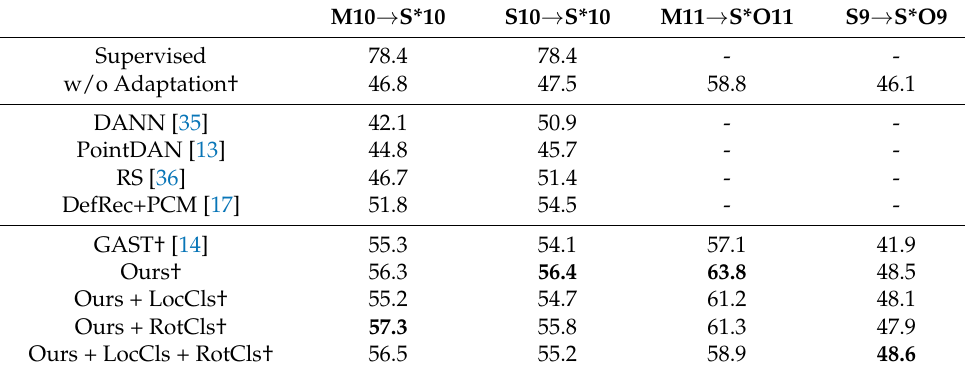
Table 4. Accuracy (%) on the PointDA and Sim-to-Real datasets. The accuracy for models marked with † is tested on our platform.